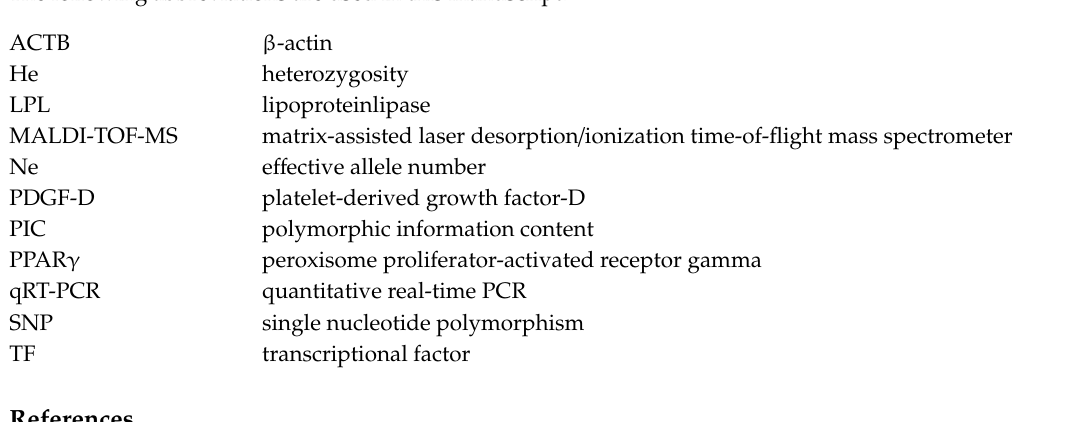
Table S1: Primers used in this study for PCR, Table S2: Primers used in this study for qRT-PCR, Table S3: The breed e ff ect, Figure S1: Detection of overexpression e ffi ciency of the PDGF-D gene. ( A ) Positive cells observed using a light microscope (20 × ). ( B ) Positive cells observed using a fluorescence microscope (20 × ). ( C ) Relative mRNA expression levels of the PDGF-D